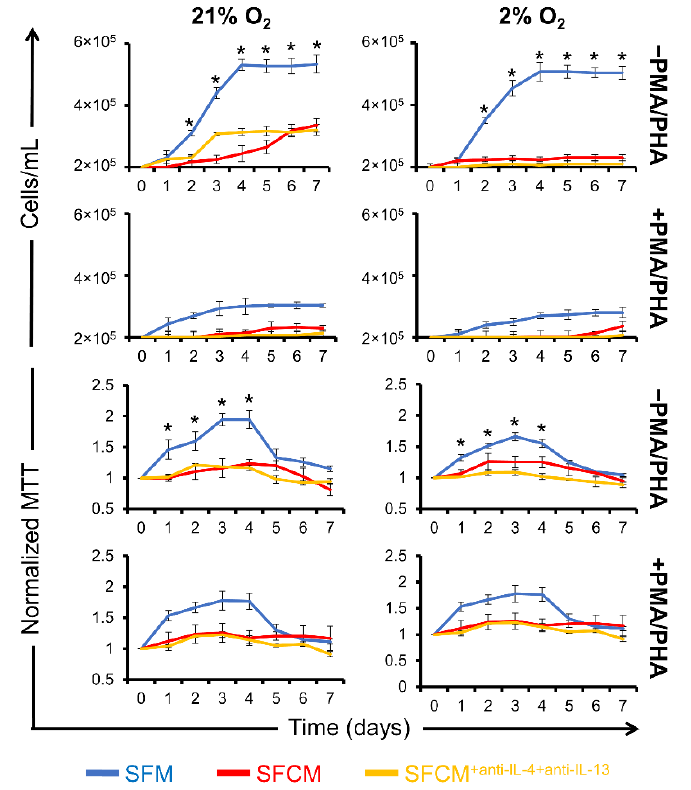
Figure 5. IL-4/IL-13-devoid SFCM failed to restore proliferation. Growth curves plotted from cell numbers (cells/mL) and optical density (O.D.) values for MTT assays for polarised and non-polarised Jurkat T cells in SFCM +antiIL − 4+antiIL − 13 compared to SFCM in air (21% O 2 ) and physoxia (2% O 2 ) environments over 7 days. Growth curves were obtained by haemocytometer-based cell counting. Data expressed as mean ± SD ( n = 3). MTT assay values at each time point were normalised to day 0. Data expressed as mean ± SD, ( n = 3), * p < 0.05.